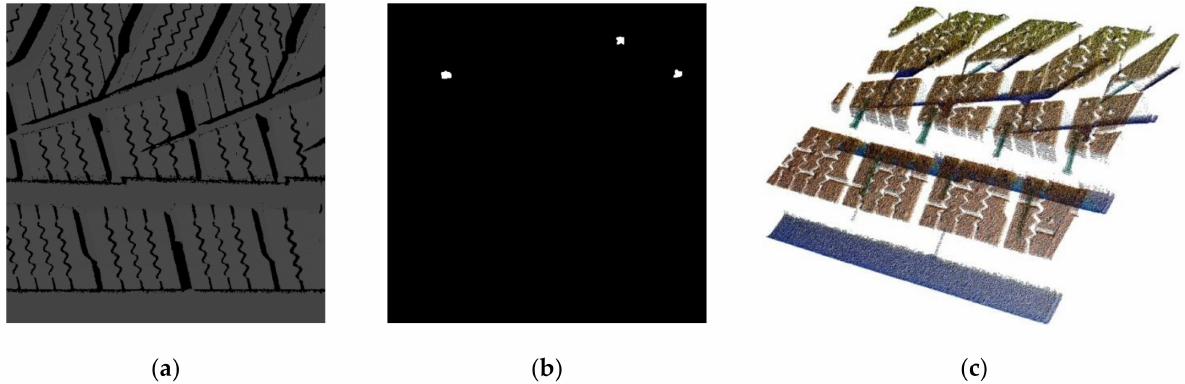
Figure 6. Tire tread image taken with a 3D camera: ( a ) original image; ( b ) label image in pixels, and ( c ) depth image expressed in